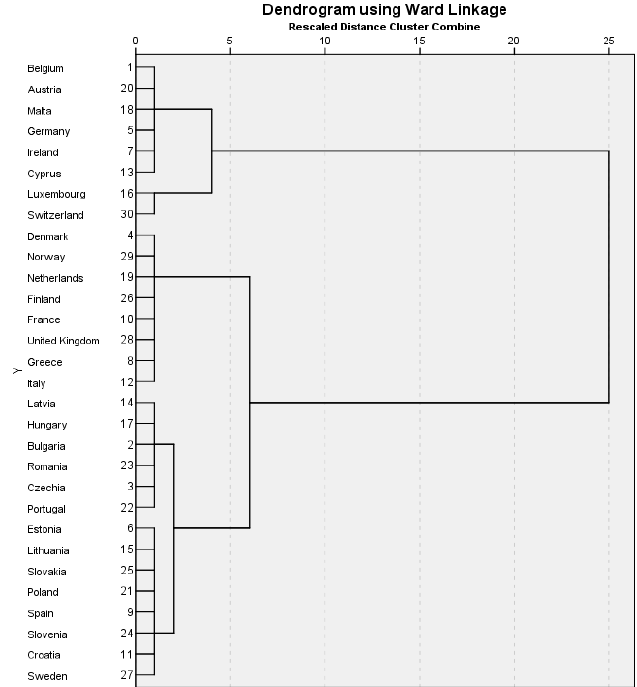
Figure 7. Dendrogram based on Ward linkage. Source: Authors’ own contribution, based on data provided by EUROSTAT.